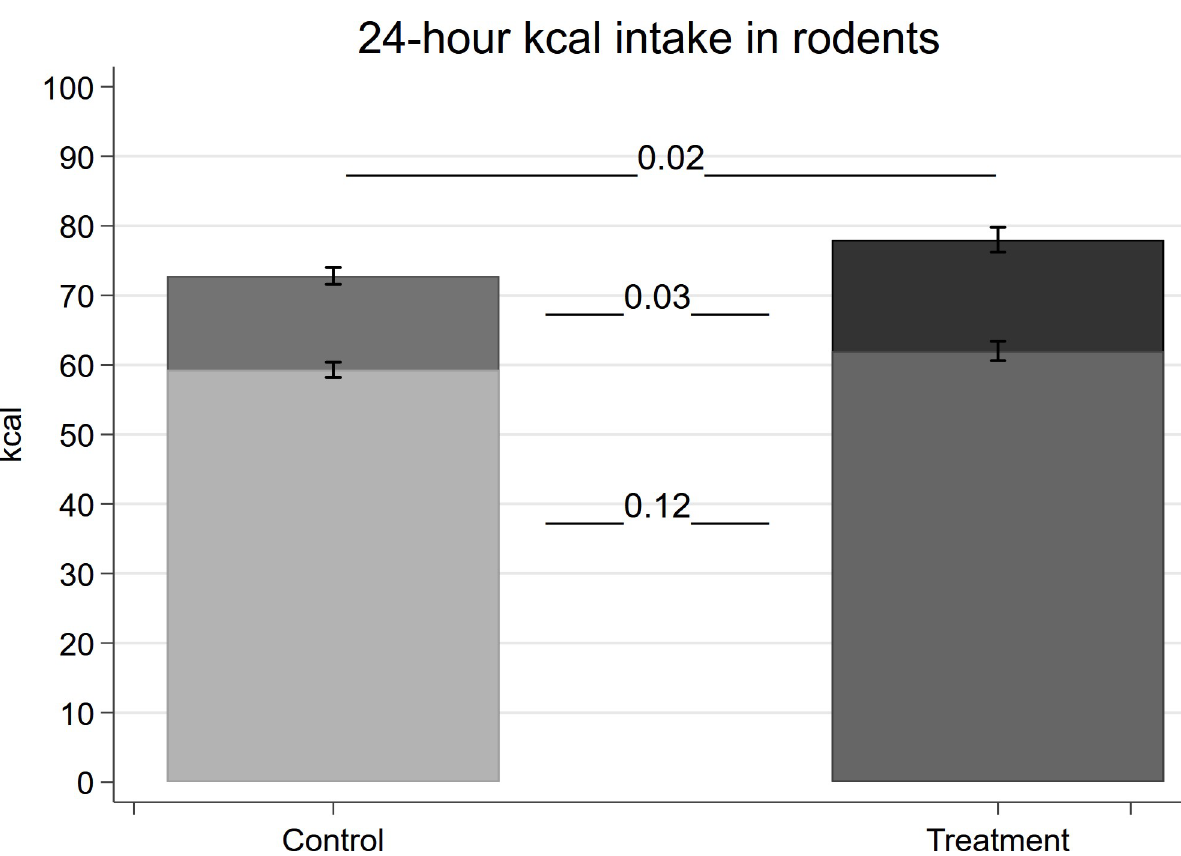
Fig 2. Consumption measures of rats. Energy intake (kcal) of rats, lighter areas in both bars indicate chow intake, darker areas above indicate sucrose intake from the first 3 hours over. Results from independent sample t-tests are presented. P-values between both foods are placed between the bars. The p-value for the overall kcal difference in 24 hours is placed above the bars. Data are presented as mean ± 1 SEM.